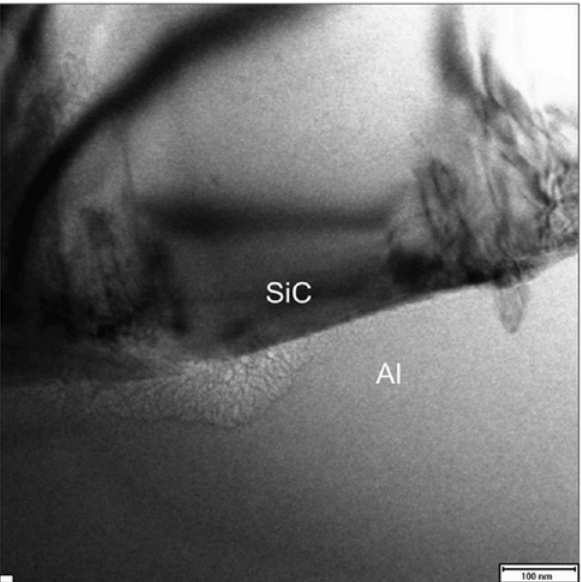
Figure 5 TEM micrographs of SiC-Al interface in 30%SiCp/2024Al composites fabricated at hot pressing temperatures of 580 ° C.